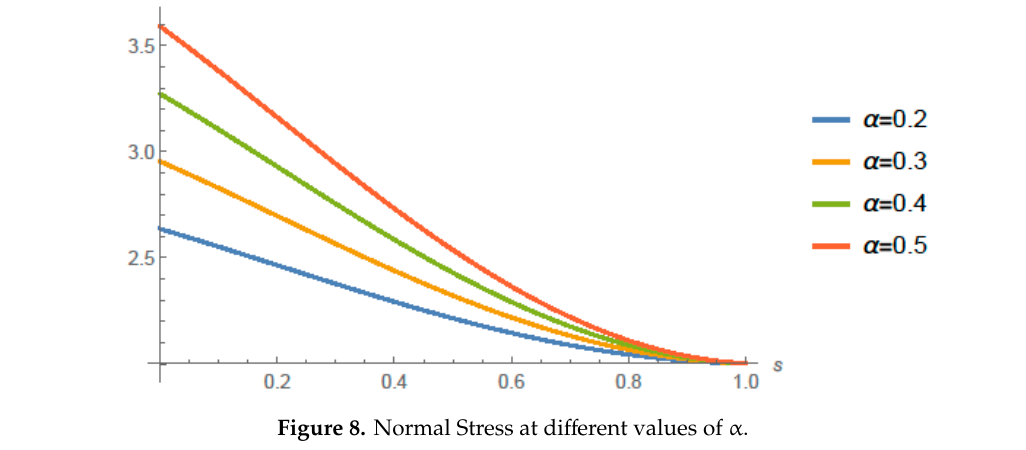
Figure 8. Normal Stress at different values of α .